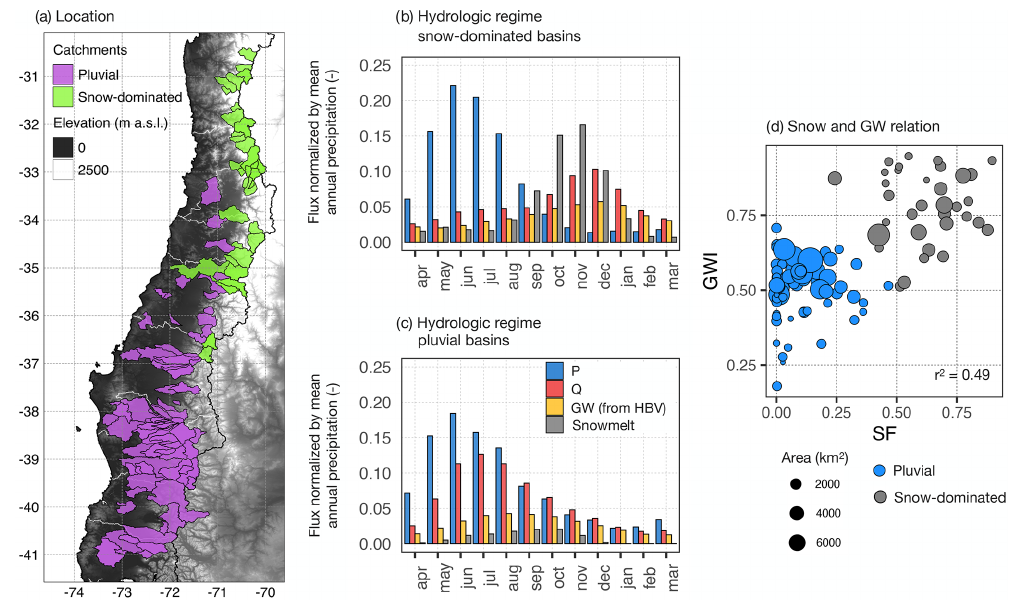
Figure 2. Characteristics of pluvial and snow-dominated basins obtained from CAMELS-CL dataset. Panel (a) presents the catchments’ location. Panels (b) and (c) present the hydrologic regimes for snow-dominated and pluvial catchments, respectively. The mean monthly fluxes of precipitation ( P ), streamflow ( Q ), and groundwater (GW) were normalized by the annual P from CAMELS-CL dataset for the period April 1979 to March 2020. Since snowmelt was obtained from a different dataset, the mean monthly snowmelt fluxes were normalized by the mean annual precipitation from ERA5-Land. Panel (d) shows the relation between GWI and SF, representing groundwater and snow storages,